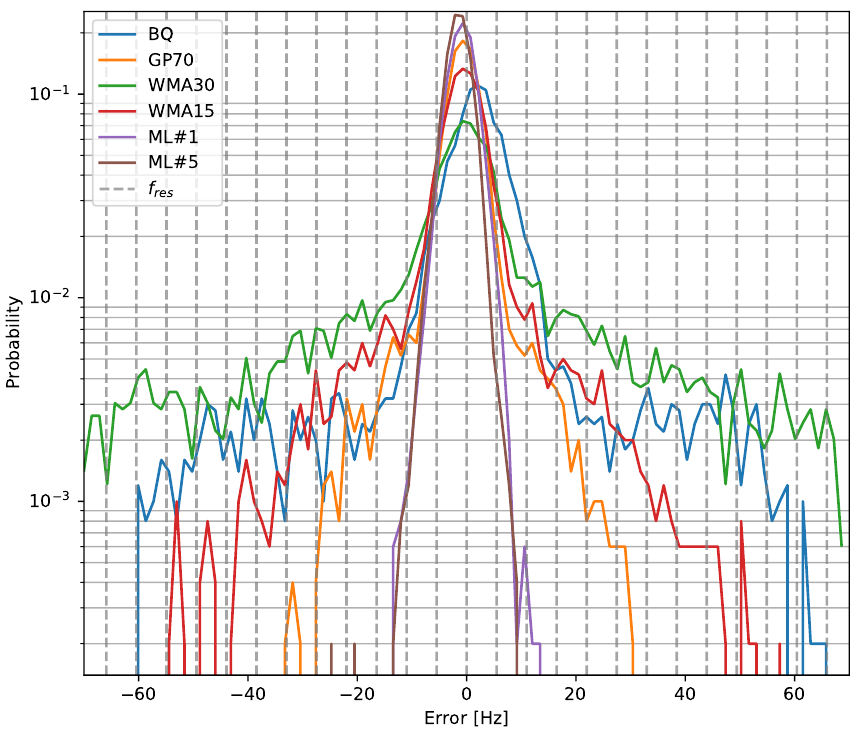
Figure 9. Error distribution of tune estimates of trained ML models and algorithmic approaches to the ground-truth resonance. ML#1 and ML#5 are the best DNN and CNN respectively; BQ is the algorithm used in the LHC until Run 2; GP70 uses Gaussian Processes with a RBF kernel having a length scale of 70; WMA15 and WMA30 use a Weighted Moving Average with half window lengths of 15 and 30